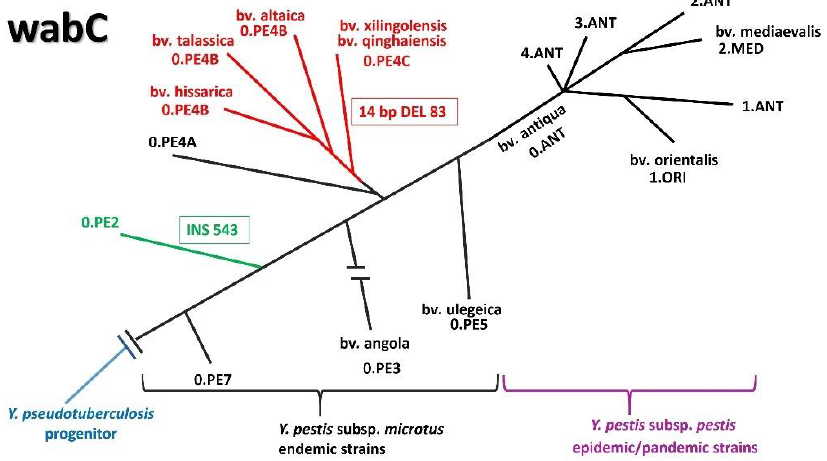
Figure 2. Schematic genomic tree and divergence based on core SNP analysis of 61 Y. pestis Genome Assembly and Annotation reports (https://www.ncbi.nlm.nih.gov/genome/browse/#!/prokaryotes/153/, accessed on 23 September 2021). The relationship among subspecies, biovars and SNP types is shown by Kislichkina [52].